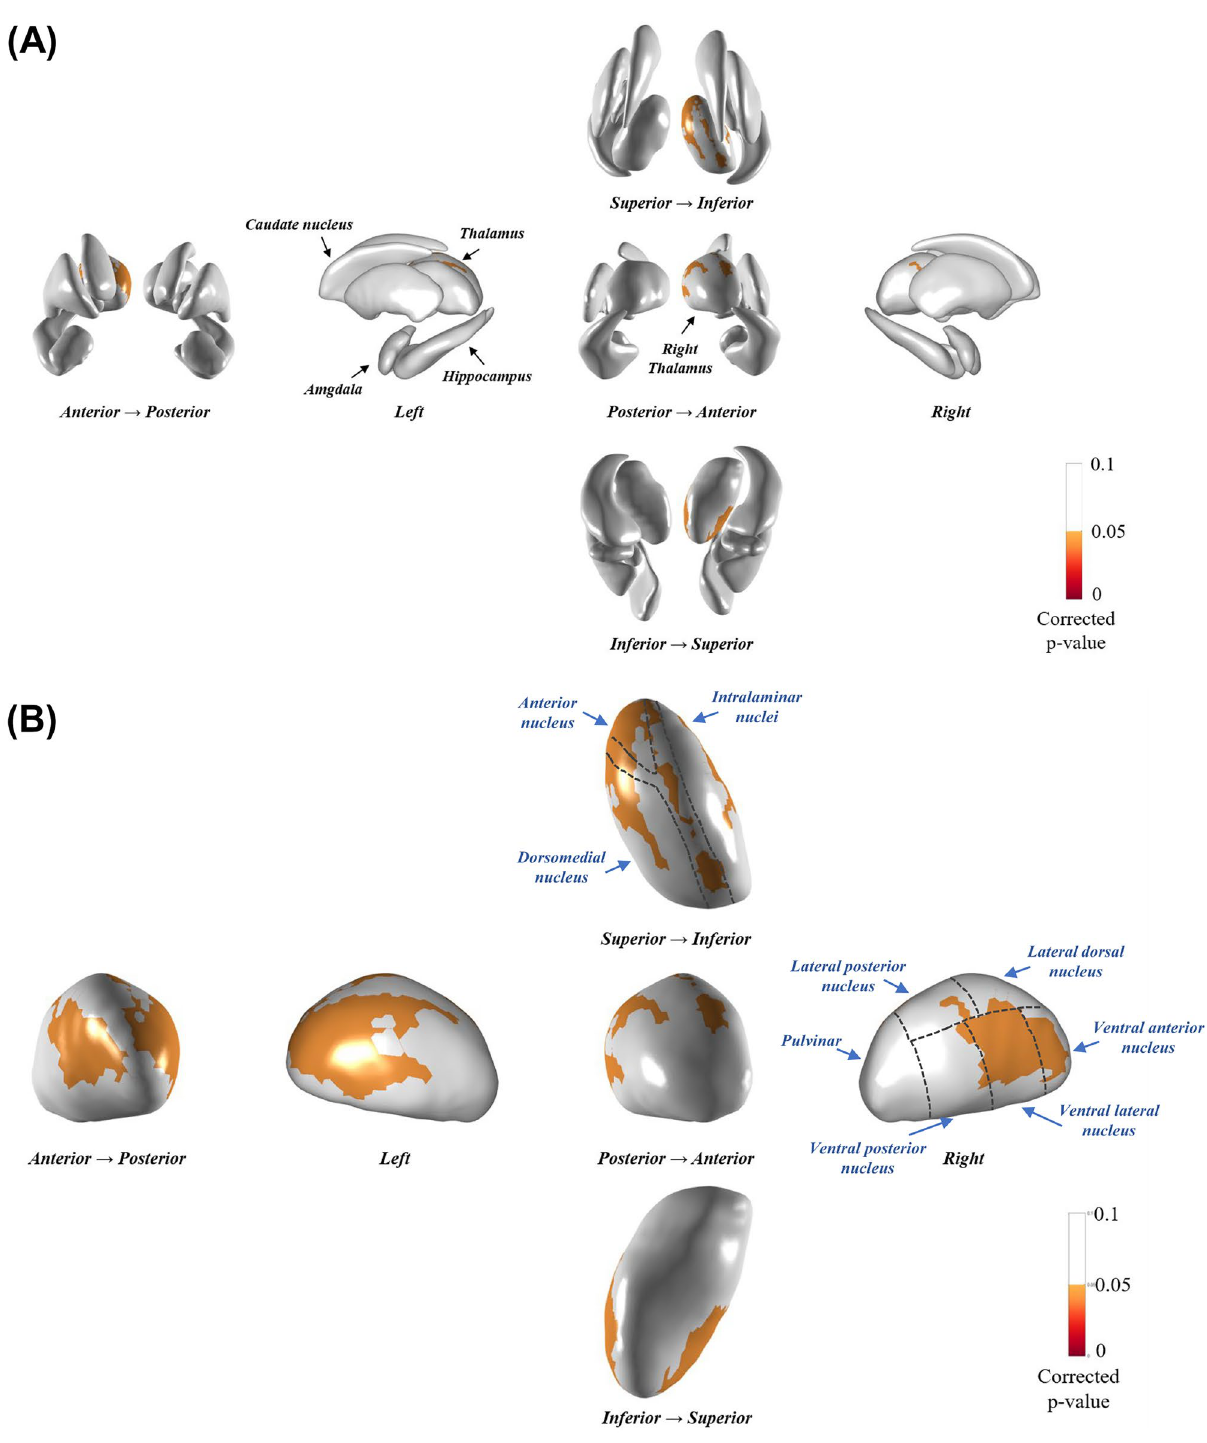
Figure 1. Comparison of the regional subcortical shape between the PD-rLID and PD-vLID groups. The results are based on an analysis of covariance, after adjusting for age, sex, disease duration, levodopa-equivalent dose increments per year, dopamine transporter availability in the posterior putamen, and intracranial volume. The cluster-based statistics-corrected statistical map ( P -map) indicates the subcortical regions that showed significant inward deformation in the latter group at the vertex level (yellow to red color). PD-rLID, PD group resistant to levodopa-induced dyskinesia; PD-vLID, PD group resistant to levodopa-induced